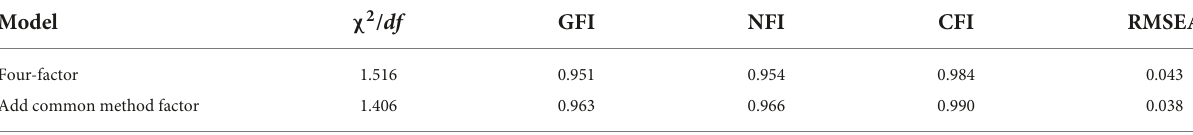
TABLE 5 Descriptive statistics and correlation